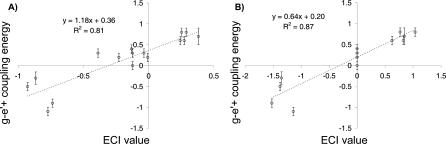
Agreement between Experimentally Measured Double-Alanine Coupling Energies and Corresponding Pair ECIThe coupling energies for residues E, Q, R, and K at g-e′+ [24] and corresponding pair ECI from the CE (in kcal/mol) are shown.(A) Energies from repacking calculations,

, were used to fit the CE.
(B)

energies were used to fit CE.